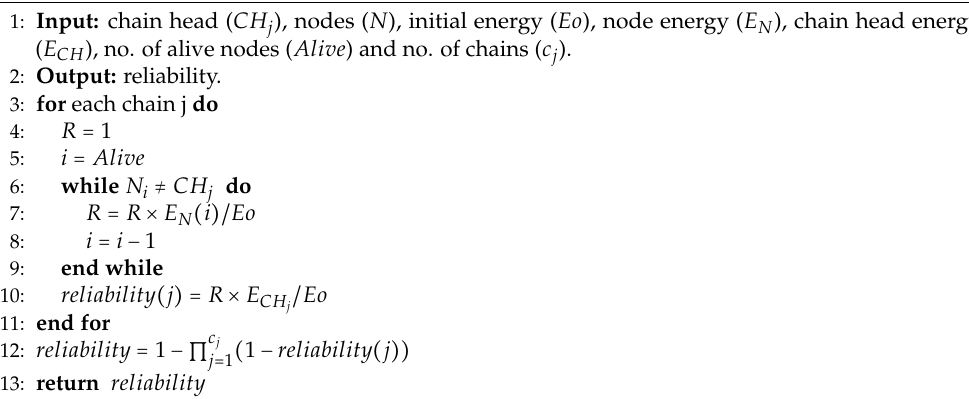
Algorithm 3 Calculate reliability of